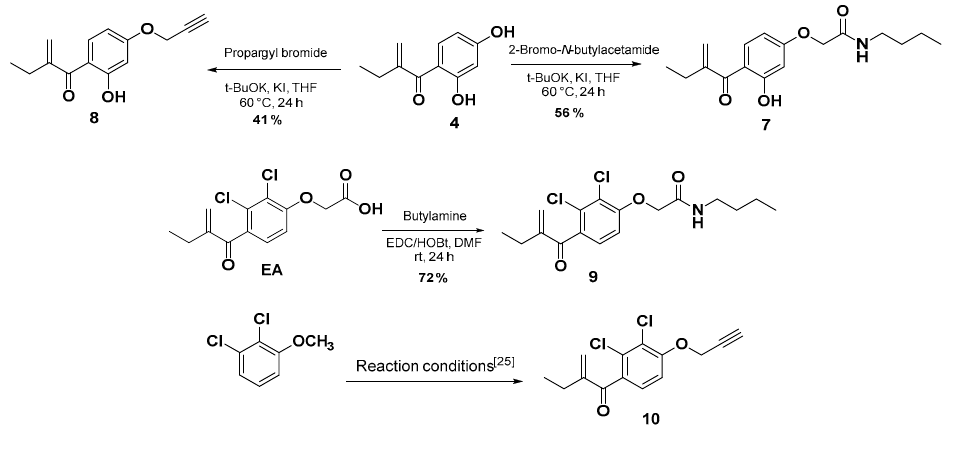
Table 1. Antiproliferative activity of EA derivatives against cancer cell line HL60 expressed in terms of IC 50 ( µ